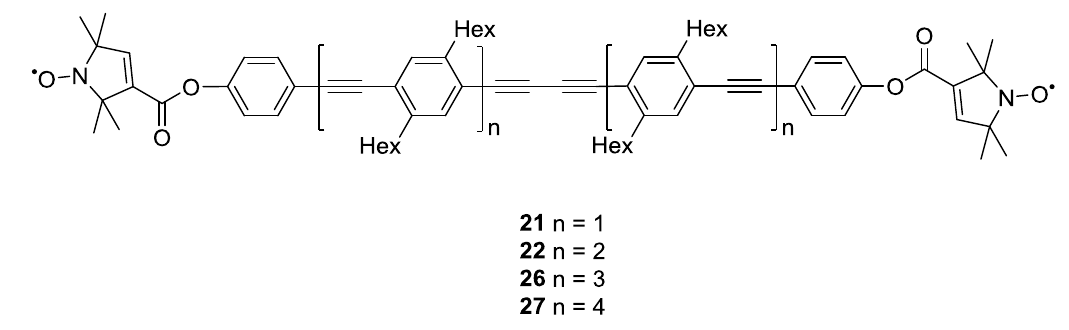
Figure 4. Poly(phenyleneethynylene)-based biradical